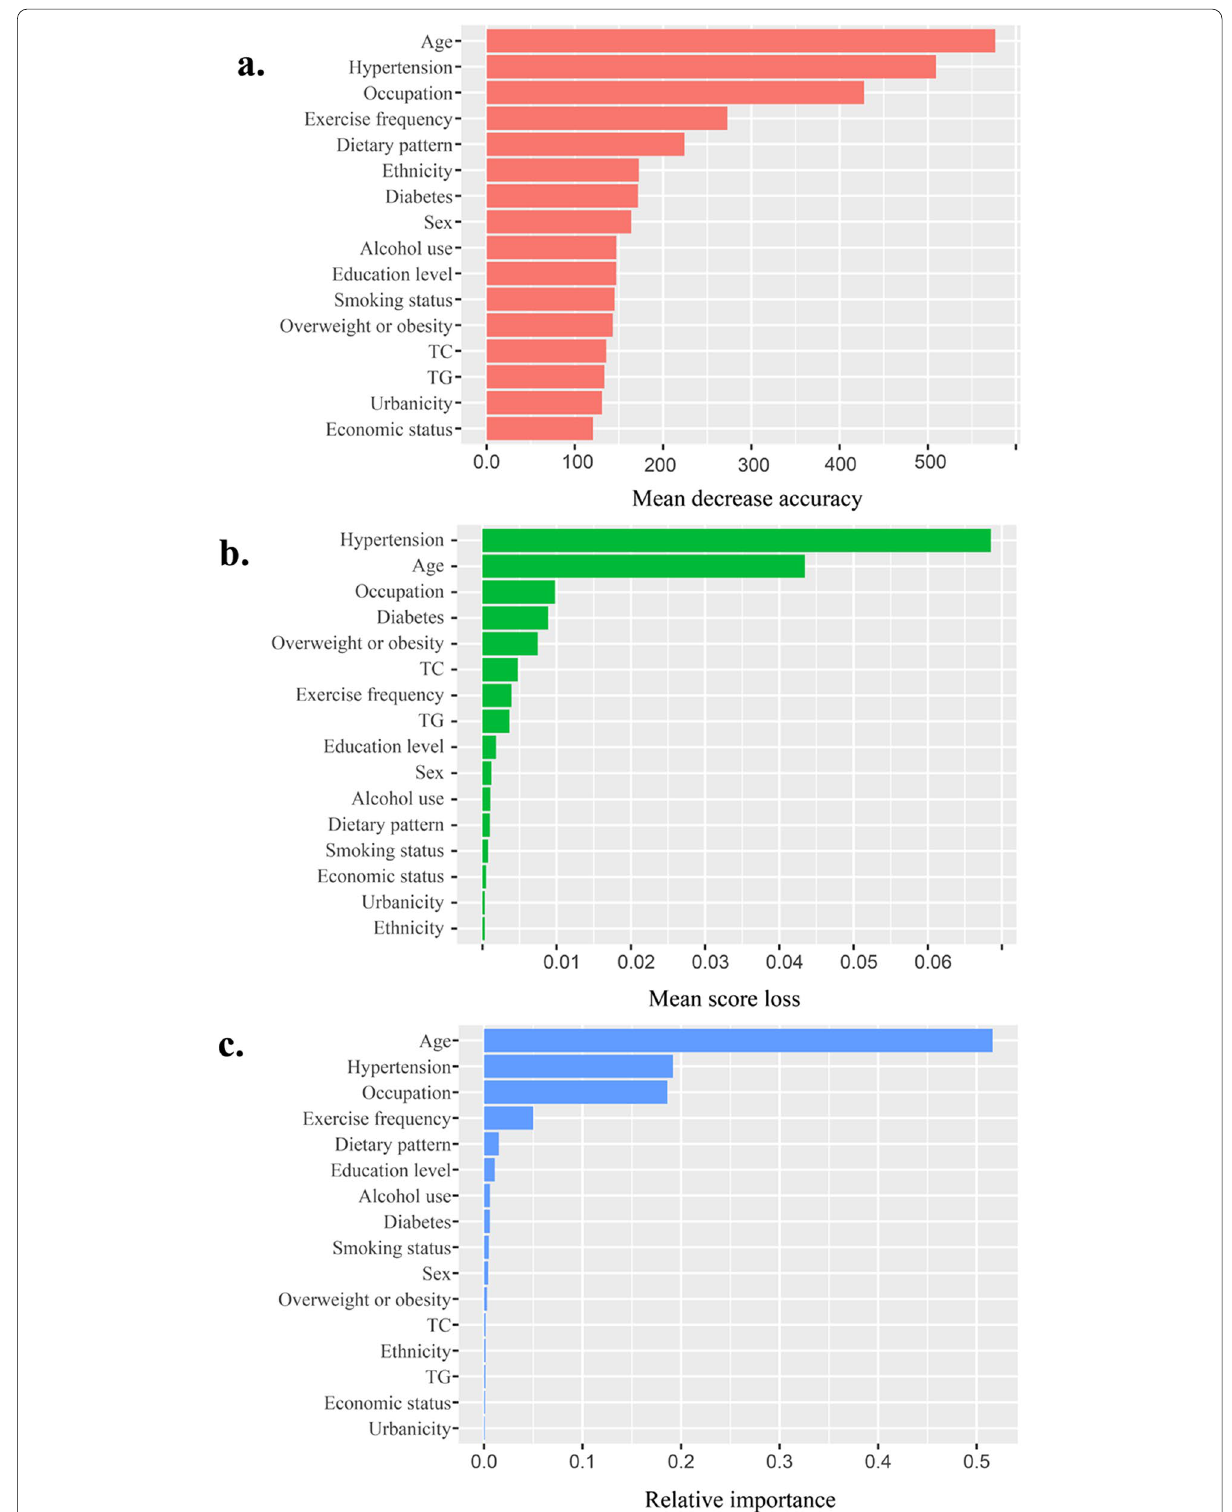
Fig. 2 ( a ) variable importance computed from Random Forest algorithm, denoted by mean decrease accuracy; ( b ) variable importance computed from Random Ferns, denoted by mean score loss; ( c ) variable importance computed from XGBoost, denoted by relative